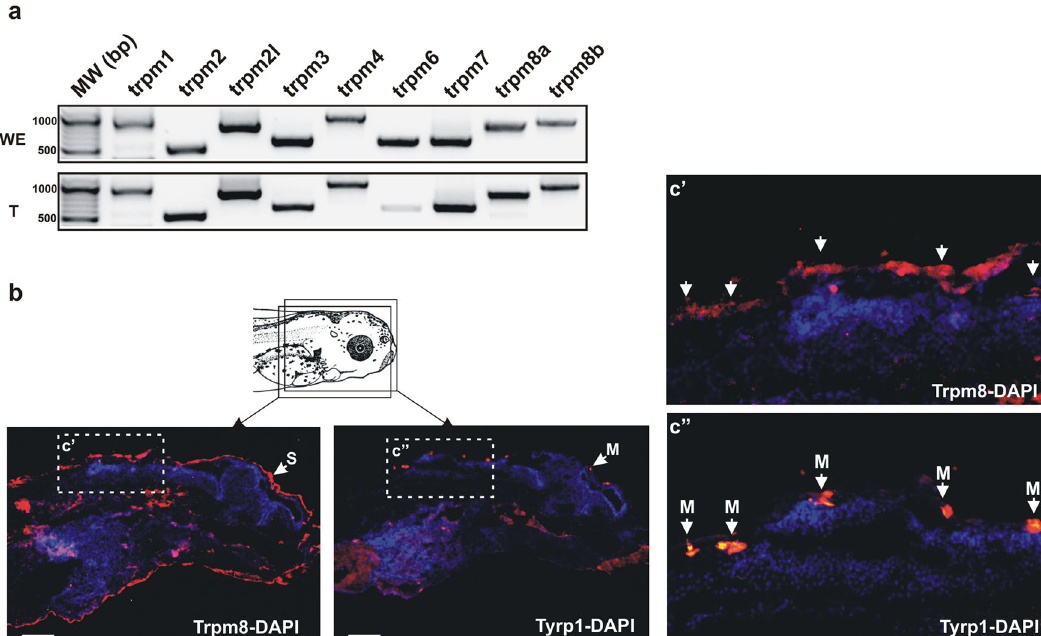
Fig. 3 trpm channel mRNA and TRPM8 protein expression by skin melanophores. a Representative RT-PCR analysis of mRNA expression for trpm1- trpm8b in the whole embryo and tail at stage 42/43 ( N = 3 independent samples). trpm6 mRNA was detected slightly in 1 of 3 independent replicates. b Immunohistochemistry against TRPM8 and Tyrosinase related protein 1 (Tyrp-1) in consecutive sections (schematic). DAPI staining (blue) was used to visualize cell nuclei and facilitate overlapping of adjacent sections. Boxed areas are shown enlarged (c ’ and c ” ). Immunolabel displays co-localization of Tyrp-1 (arrows) in melanophores (M) of the skin (S) with Trpm8. Scale bar = 100 µ